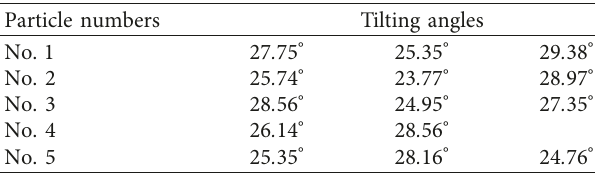
Table 3: DEM parameter